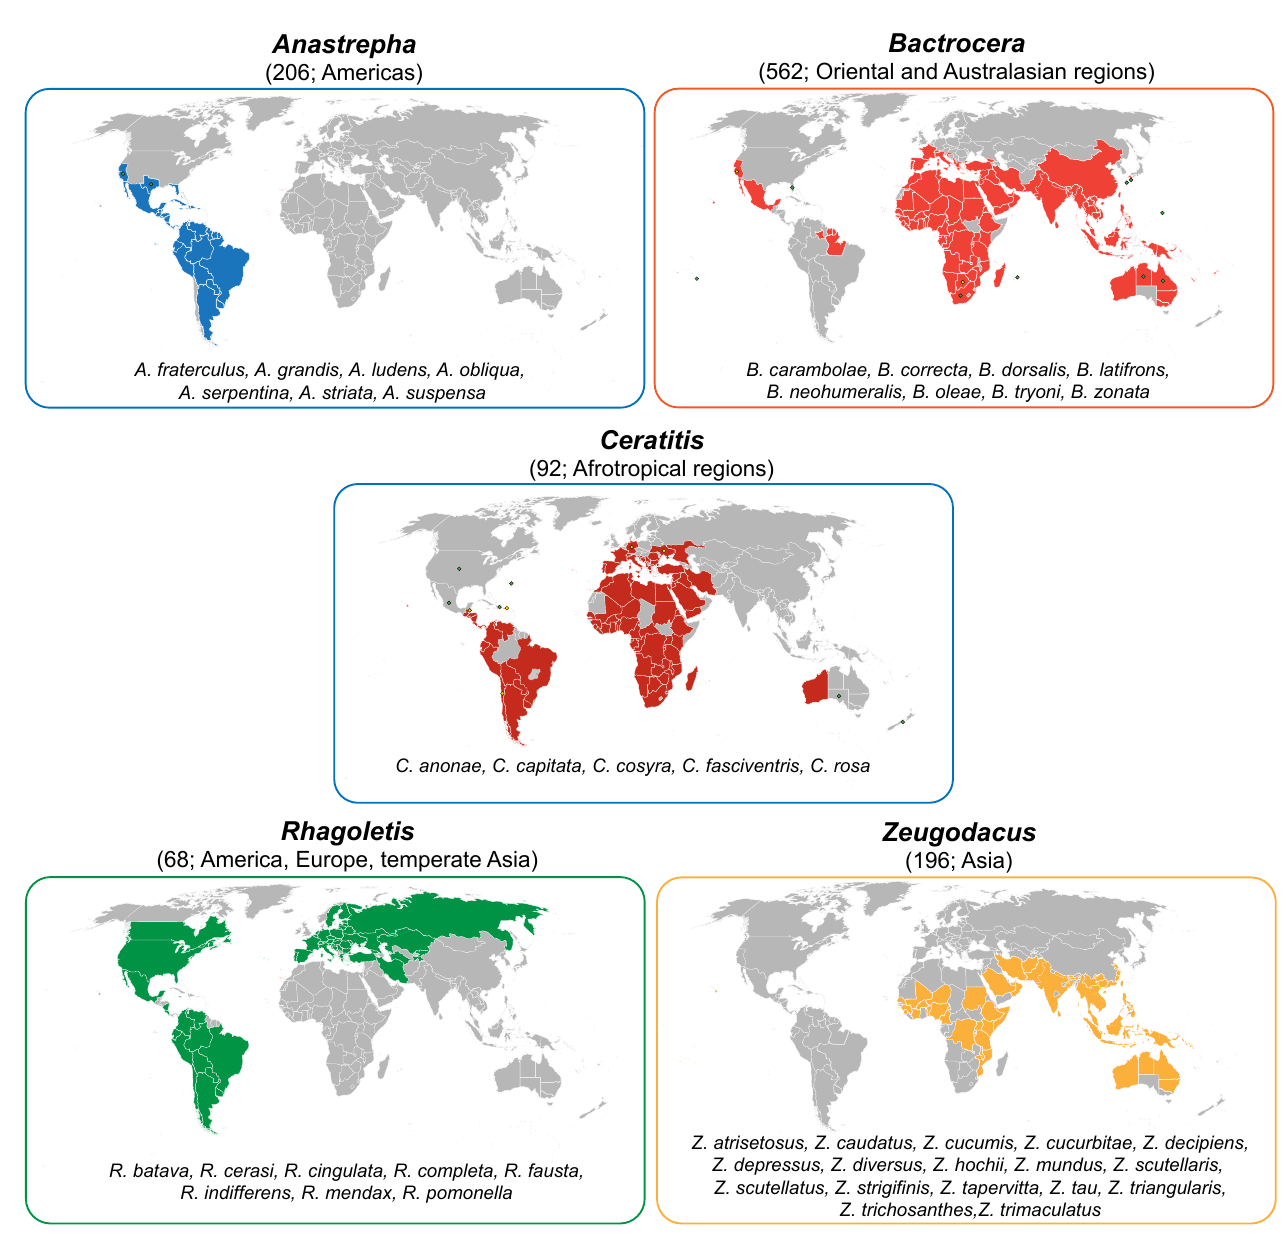
Figure 1. Worldwide distribution of species belonging to the Anastrepha , Bactrocera , Ceratitis , Rhagoletis and Zeugodacus genera. The map is based on the currently available distribution data of species belonging to each genus retrieved from the EPPO Global Database (https://gd.eppo.int) (accessed on 13 November 2020) and integrated with information from CABI (https://www.cabi.org/isc/) (accessed on 13 November 2020) and the literature. In brackets, the total number of living species (obtained from Catalogue of Life: 2019 Annual Checklist [40] and [39]) for each genus and the original geographic range are reported. Lists of the major pests within each genus are also indicated. Background map was retrieved from https://freevectormaps.com/world-maps/WRLD-EPS-01-0011?ref=atr (accessed on 29 July 2020). Information about the status of invasion is reported in more details for the species A. ludens , B. dorsalis and C. capitata , for which yellow and green dots indicate transient presence or achieved eradication,